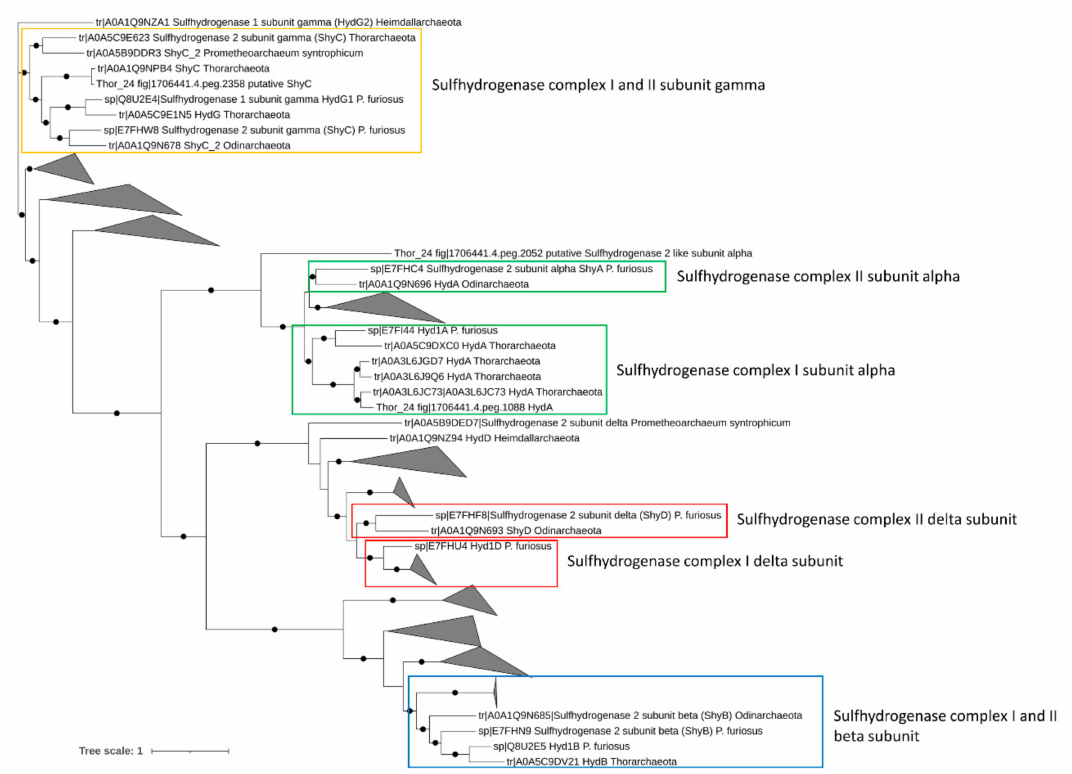
Figure 3. Phylogenetic three of sulfhydrogenase complex I and II genes in Mar Piccolo Asgardarchaeota. Only nodes supporting a bootstrap value above 0.7 are shown. GenBank Accession numbers and Uniprot accession numbers are